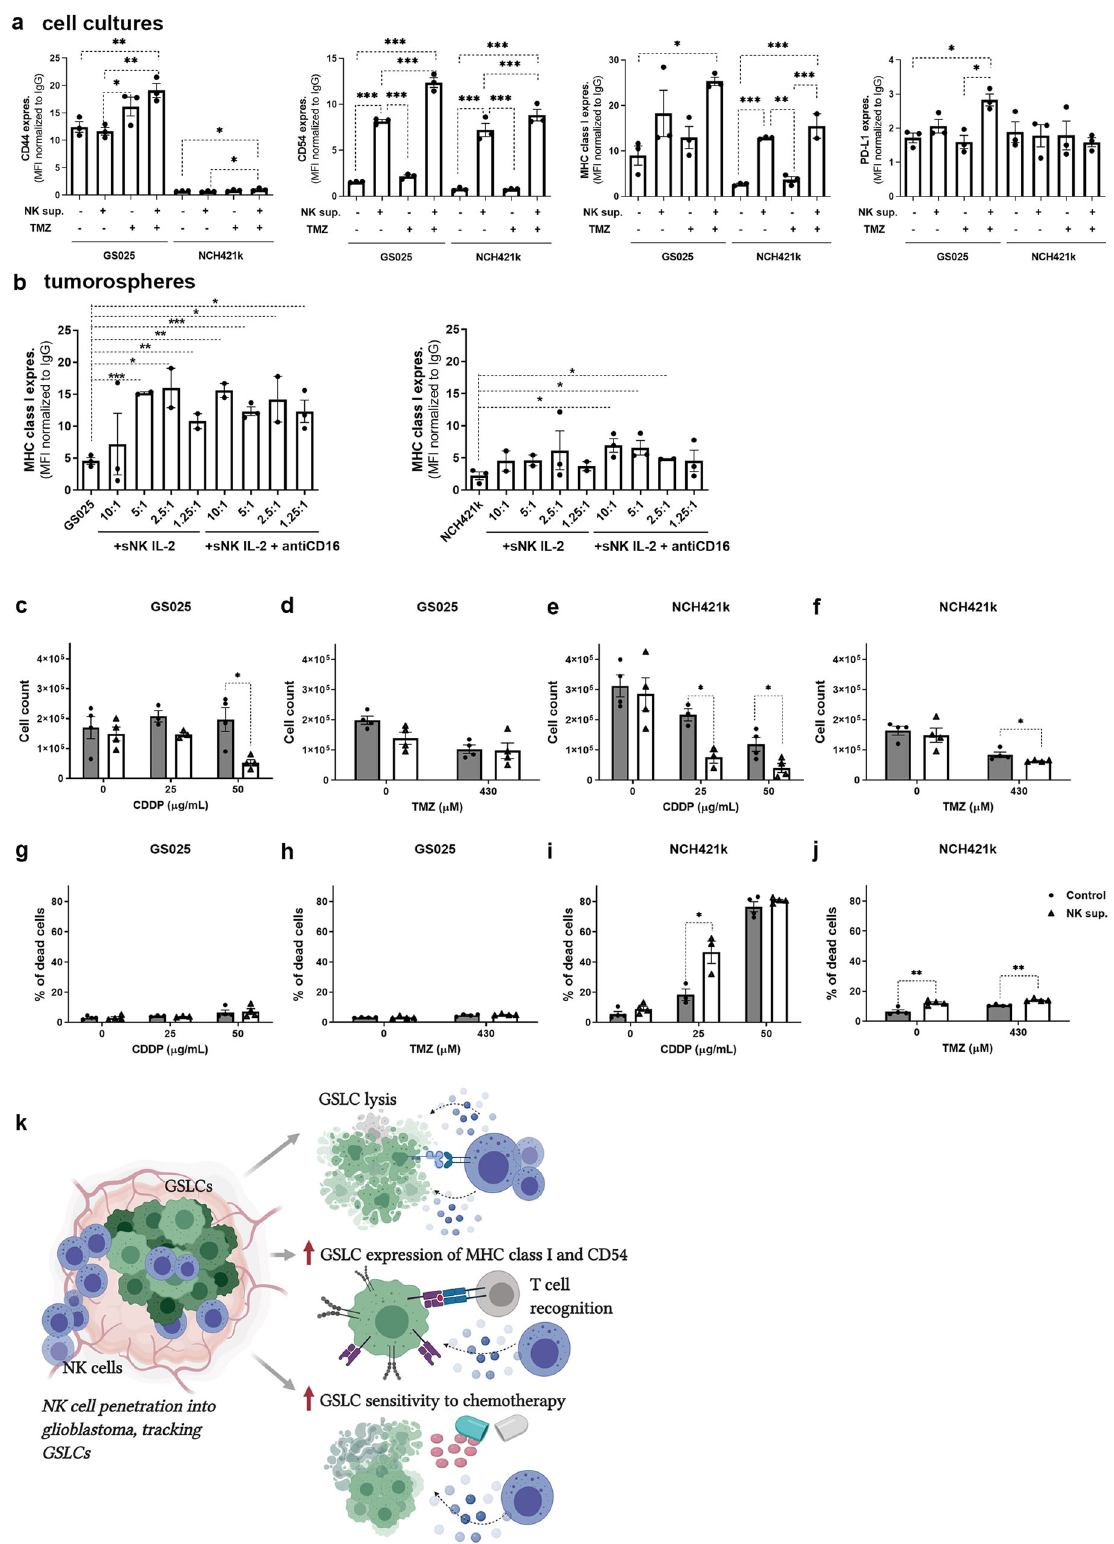
cells killed more GSLCs in both 2D and 3D in vitro models. Moreover, CD16 down-regulation in NK cells by monoclonal antibody treatments, mimicking the in vivo split anergized cells, decreased the cytotoxicity of primary and super-charged NK cells against